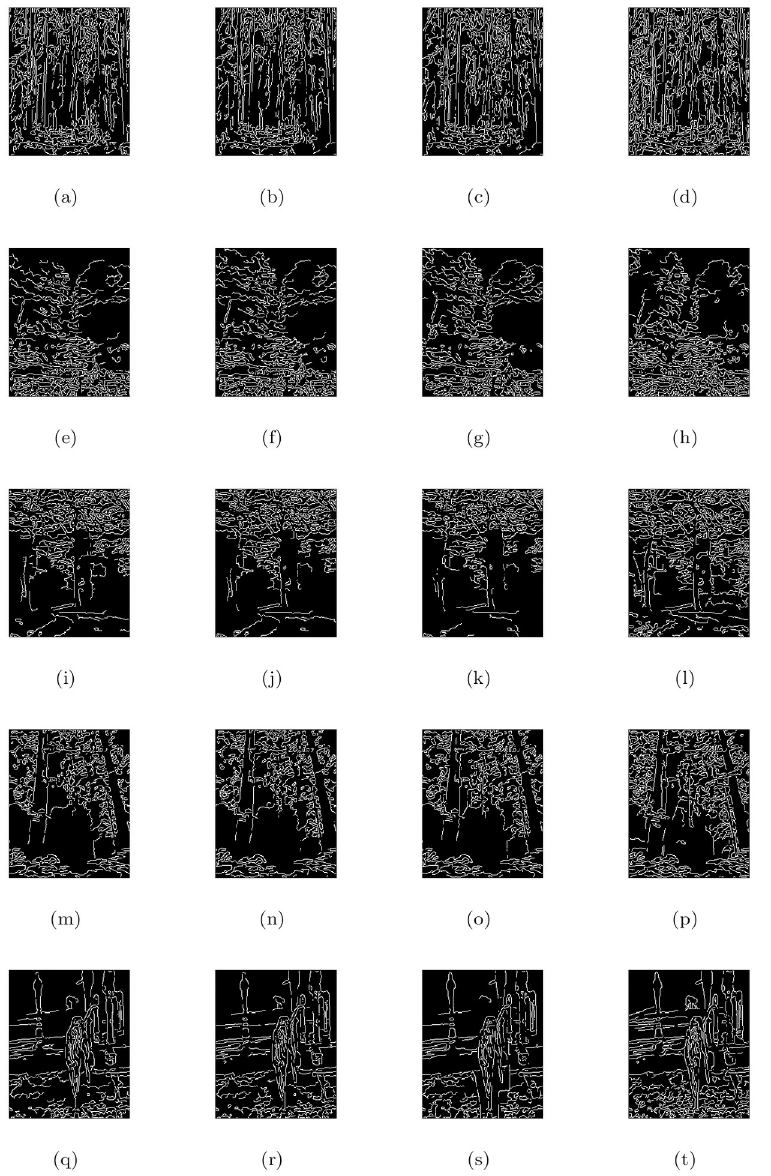
Fig 10. Corresponding visible edge maps of Fig